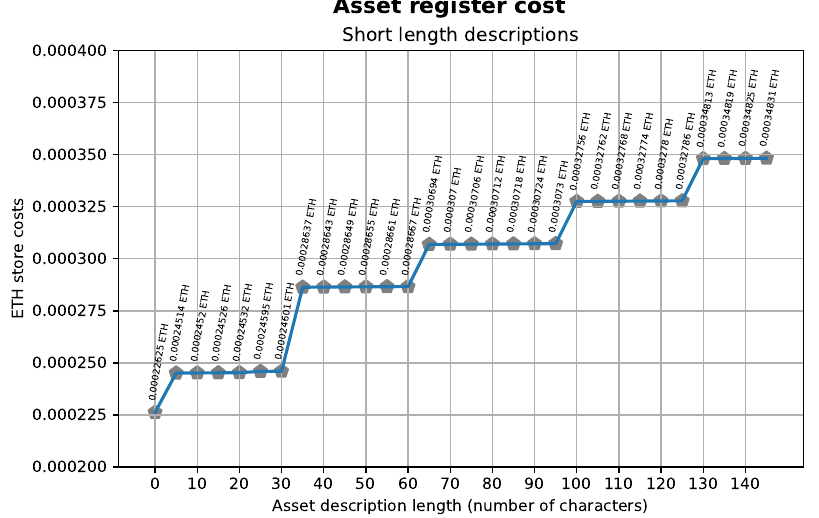
Figure 13. Ethereum cost to save a short length string description for the assets in blockchain by the DAPP. In total, 0 characters cost ETH 0.00022625, and 145 characters cost ETH 0.00034831.